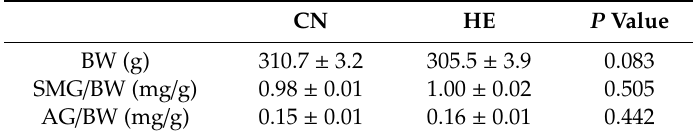
Table 1. Body weight (BW), submandibular gland (SMG) and adrenal gland (AG) weight of the control (CN) and heat-exposed (HE)